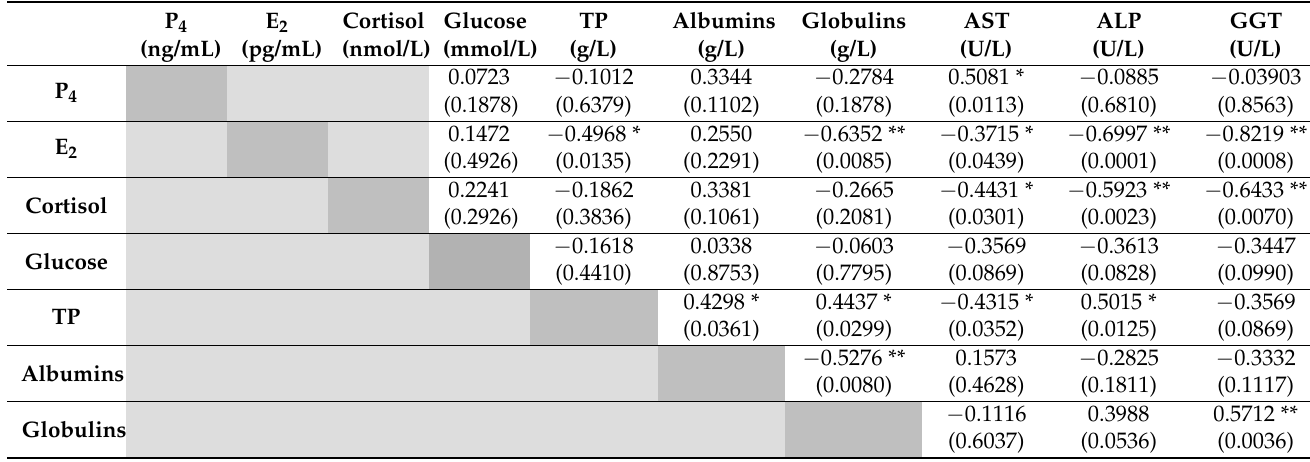
Table 8. Pearson correlation coefficient between steroid hormones, glucose, total proteins, albumins, globulins, AST, ALP and GGT in non-pregnant non-lactating ( n = 14), non-pregnant lactating ( n = 8) and pregnant ( n = 38) she-camels. P 4